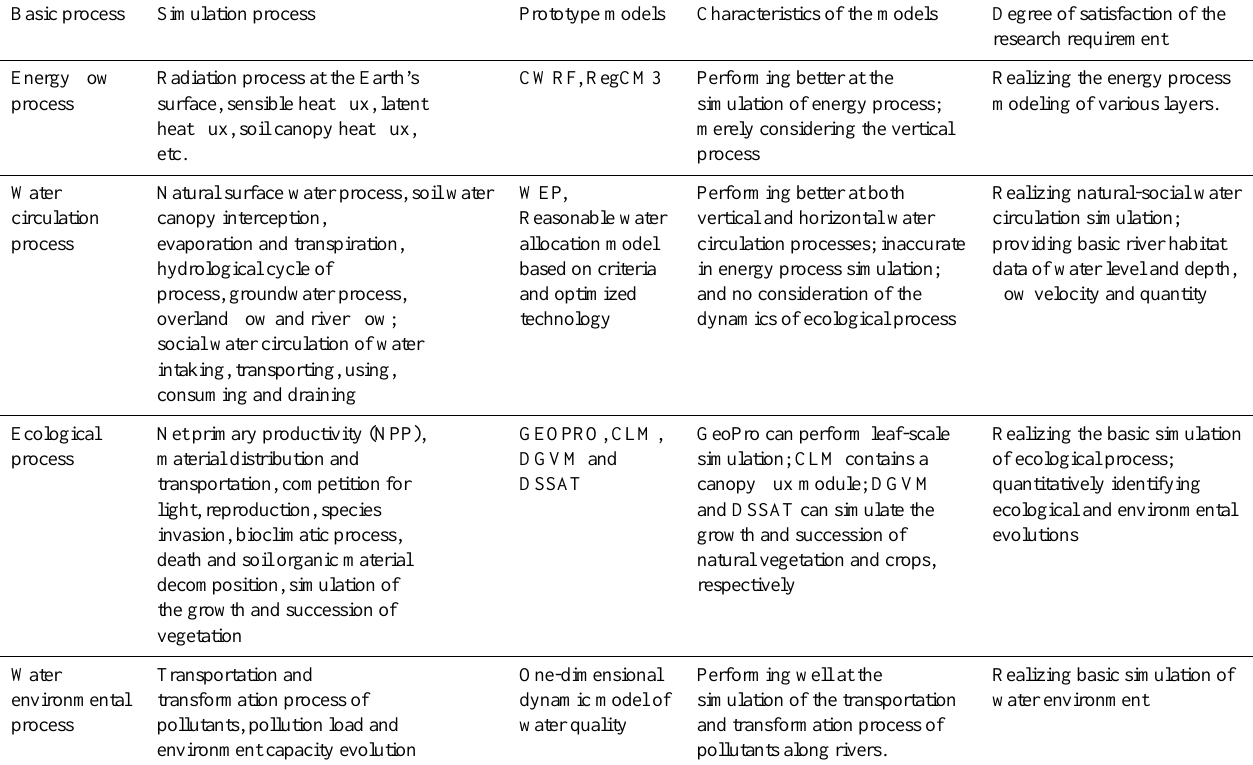
Table 1. Selection of essential simulation process and the prototype